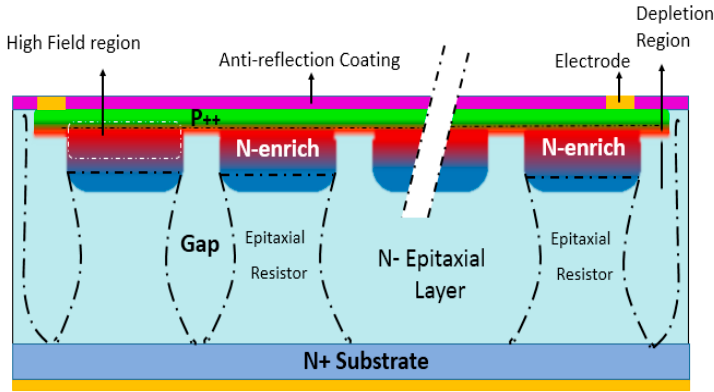
Figure 1. Schematic structure of EQR SiPM; APD cell consists of N-enriched regions forming high electric fields between the N-type epitaxial silicon wafer and the P++ surface layer, the un-depleted region in the epitaxial silicon layer below the P/N junction as the quenching resistor, and the APD cells are isolated from each other by the depletion regions.